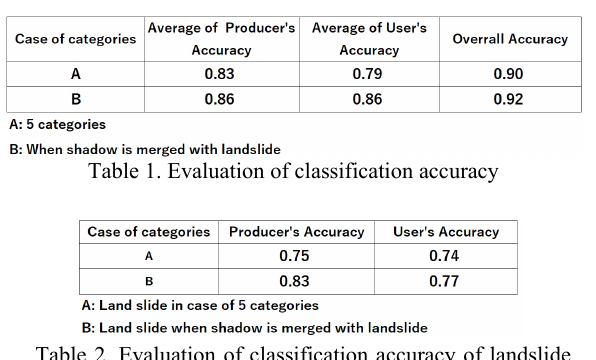
(c) Evaluation data based on classification results Figure 9. Verification of classification accuracy in the evaluation area